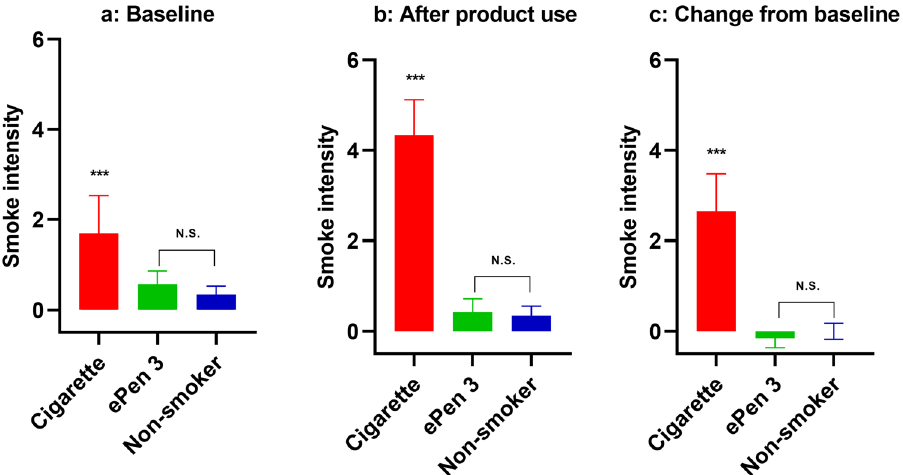
Figure 2. Differences in smoke intensity scoring before and after product use. Values are mean and SD of CSs, ECs and NSs (n = 11 each group) at baseline ( a ), after product use (cigarette and e-cigarette groups only) ( b ) and differences from baseline ( c ). ***p <